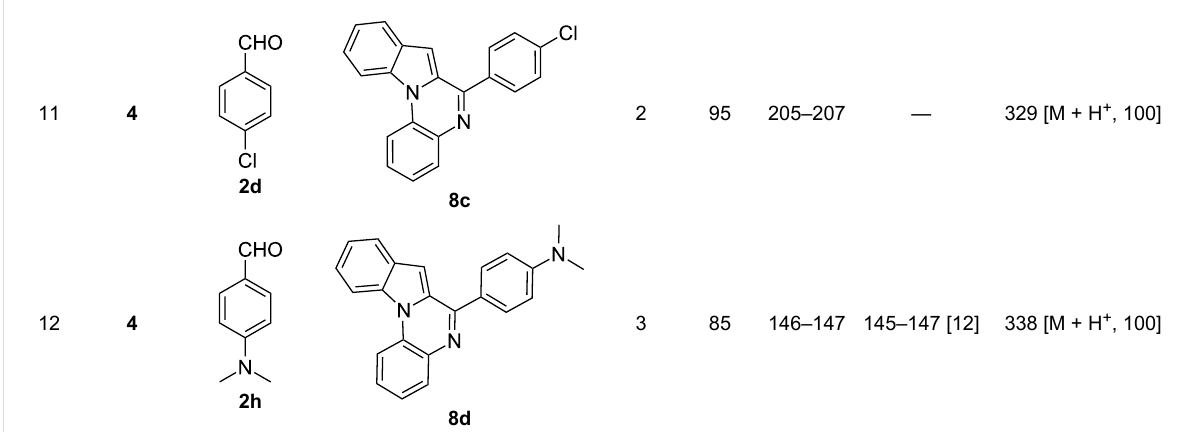
Table 2: Condensation of the Pictet–Spengler substrates 1 and 4 (1 equiv) with aldehyde (1 equiv) in the presence of TCT (20 mol %) in DMSO under a nitrogen atmosphere.